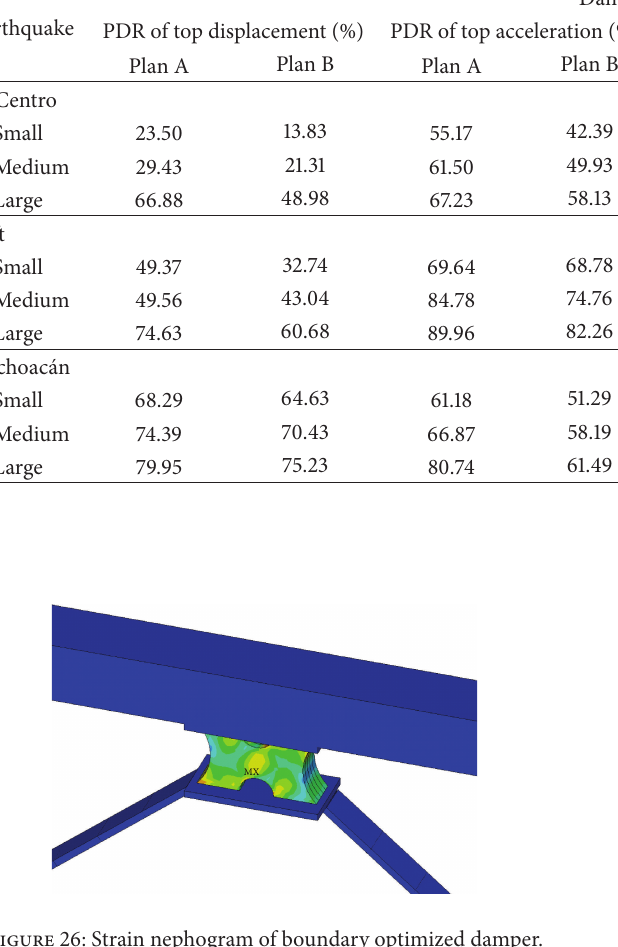
Figure 26: Strain nephogram of boundary optimized damper.